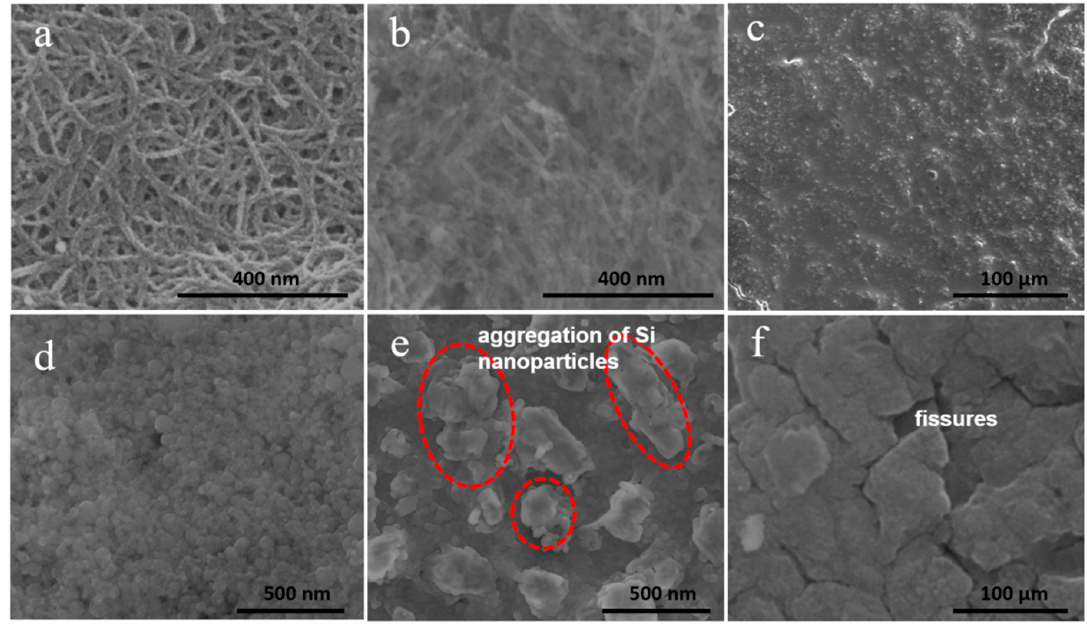
Figure 8. SEM images of Si/SiC/CNT composite before cycling ( a ) and after 100 cycles ( b ). SEM image of Si/SiC/CNT electrode after 100 cycles ( c ). SEM images of pure Si material before cycling ( d ) and after 100 cycles ( e ). SEM image of pure Si electrode after 100 cycles ( f ). Nanomaterials 2019 , 9 , x FOR PEER REVIEW